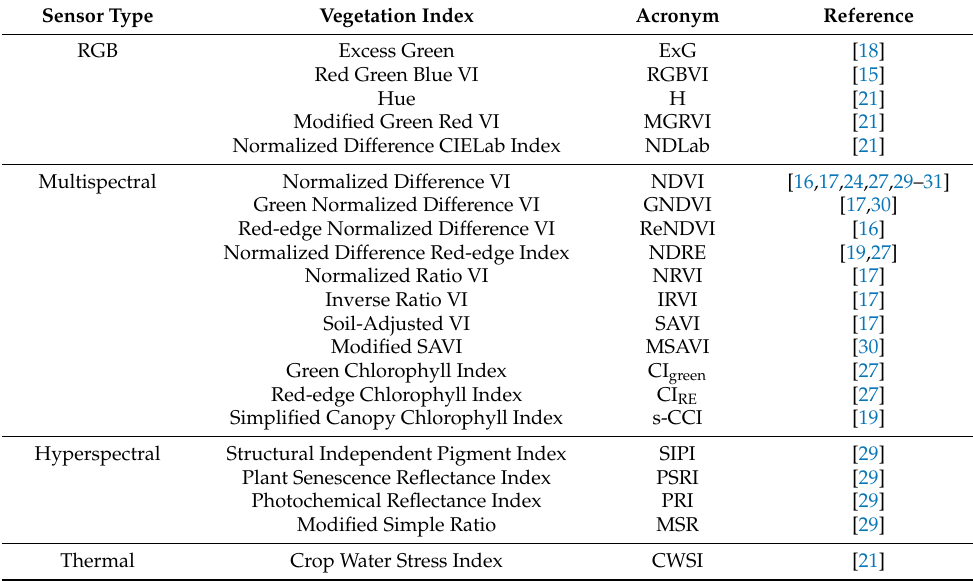
Table 1. Vegetation indices (VIs) applied in the papers published in this special